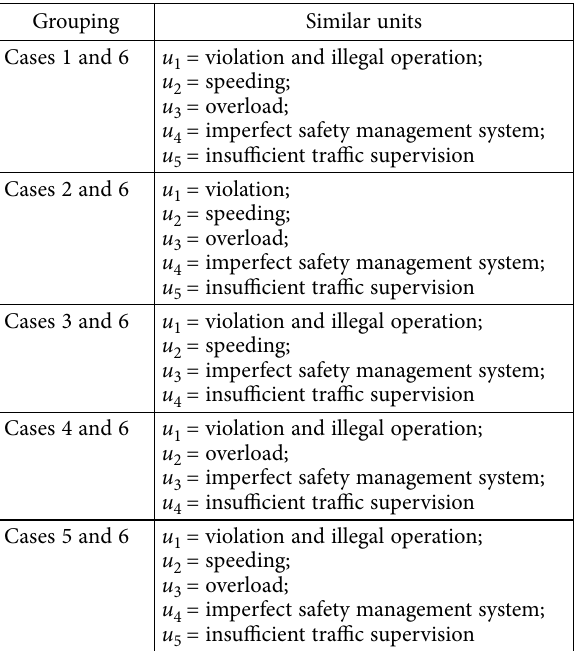
Table 8. The similar units of the five groups Grouping Similar units